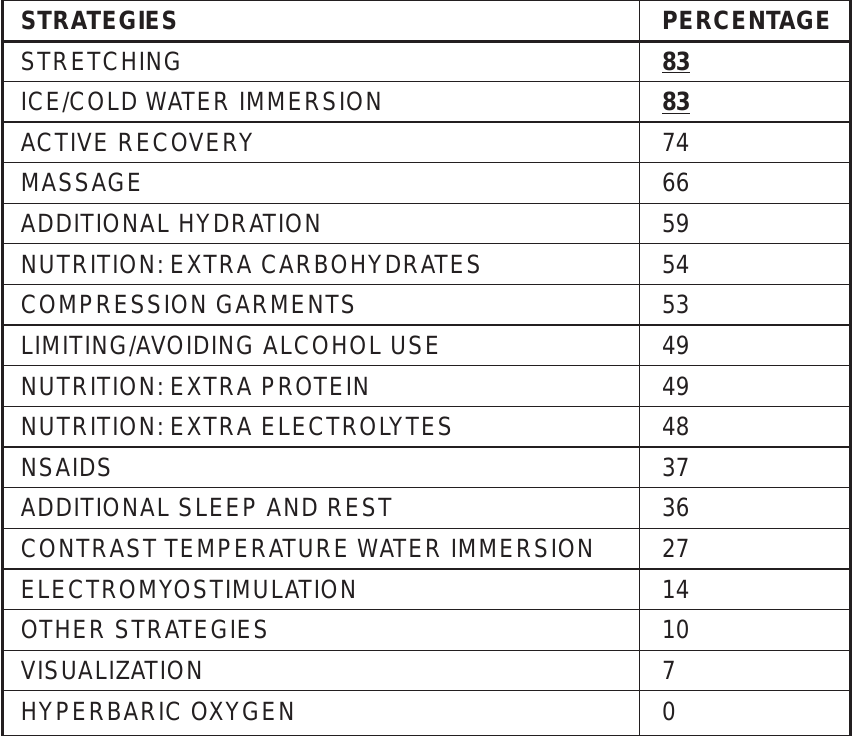
Table 2: Recovery strategies used by respondents arranged in order